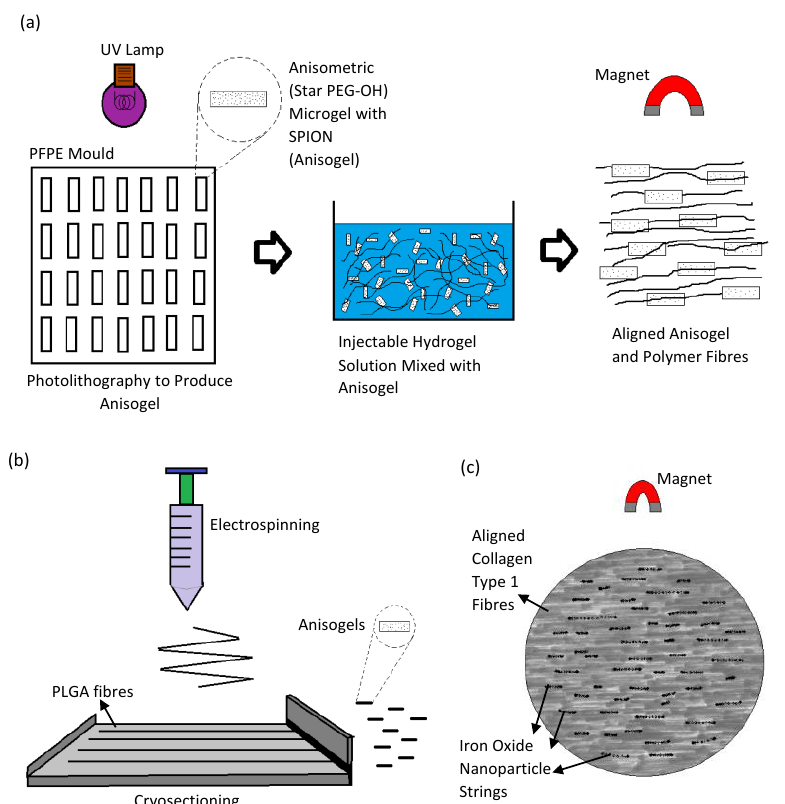
Figure 8. Magnetic orientation method. ( a ) The production of anisogels using a photolithography method. ( b ) Anisogels produced by using a electrospinning and cryo-sectioning. ( c ) Direct application of iron oxide nanoparticles into injectable collagen